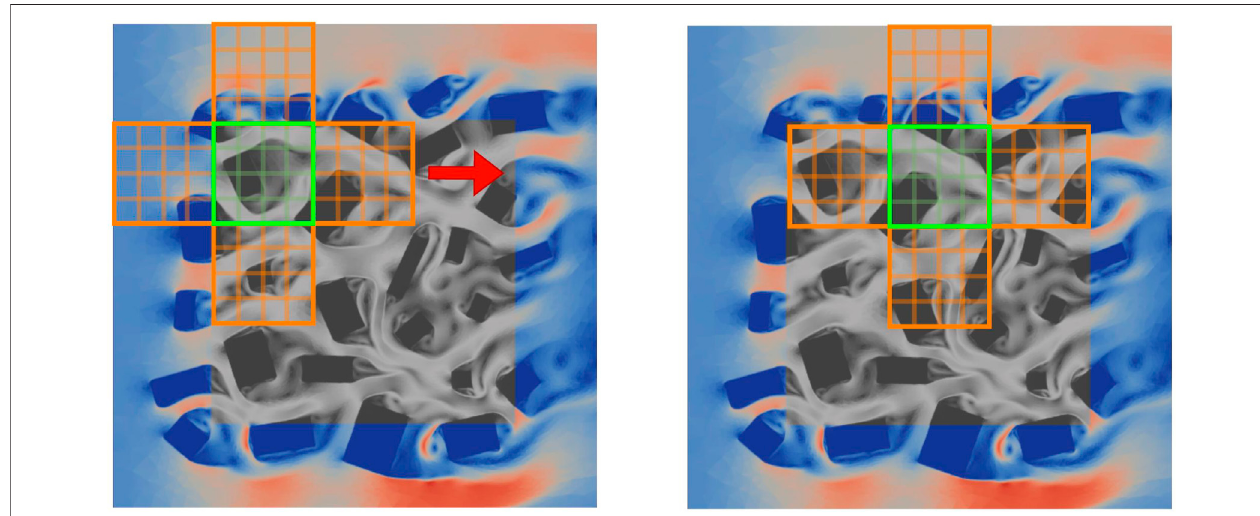
FIGURE 4 | Greyscale regions indicate the area where we seek a solution. The coloured regions show the magnitude of the velocity of the imposed boundary conditions.Left:Usingthelatestsolutionsofthefourneighbouringsubdomains(indicatedinorange),andtheprevioussolutioninthecentralsubdomain(showningreen) and the buildings fi elds in the central subdomain, a prediction is made for the central subdomain. Right: move to the next set of fi ve subdomains and predict for the next central